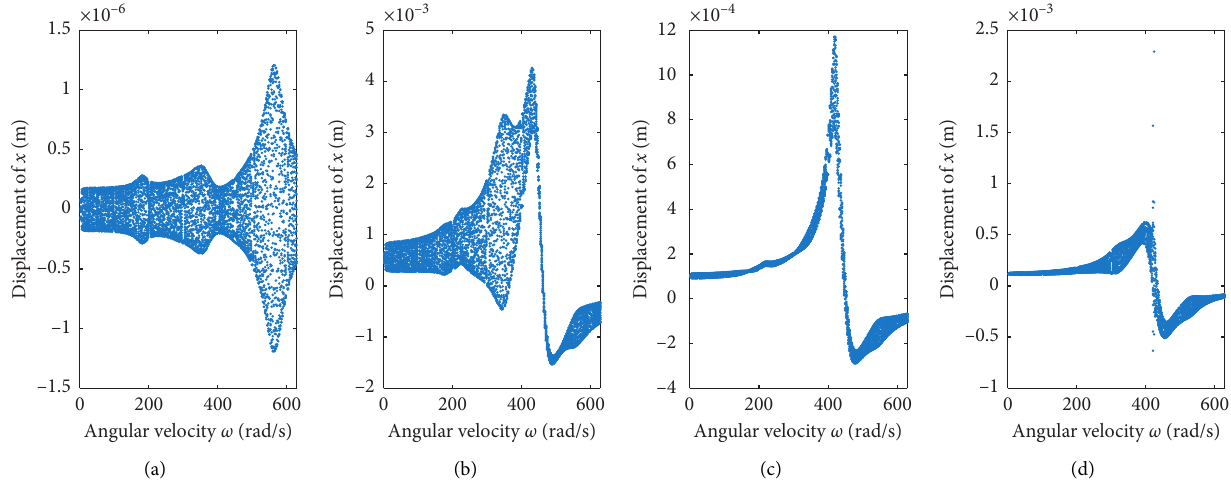
Figure 8: Bifurcation diagram of rotor system with demagnetization angle variation. (a) β � 0, (b) β � π /6, (c) β � π /3, (d) β � π